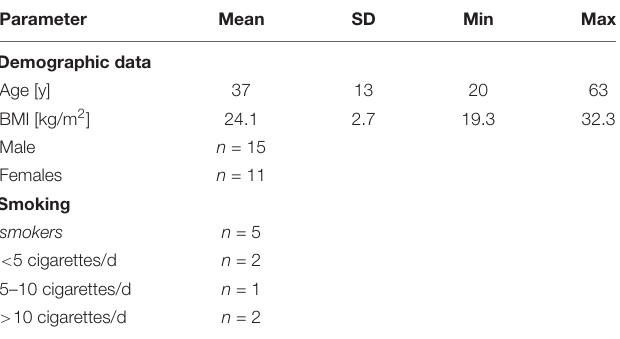
TABLE 2 | Demographic data of the test sample including 26 healthy volunteers.